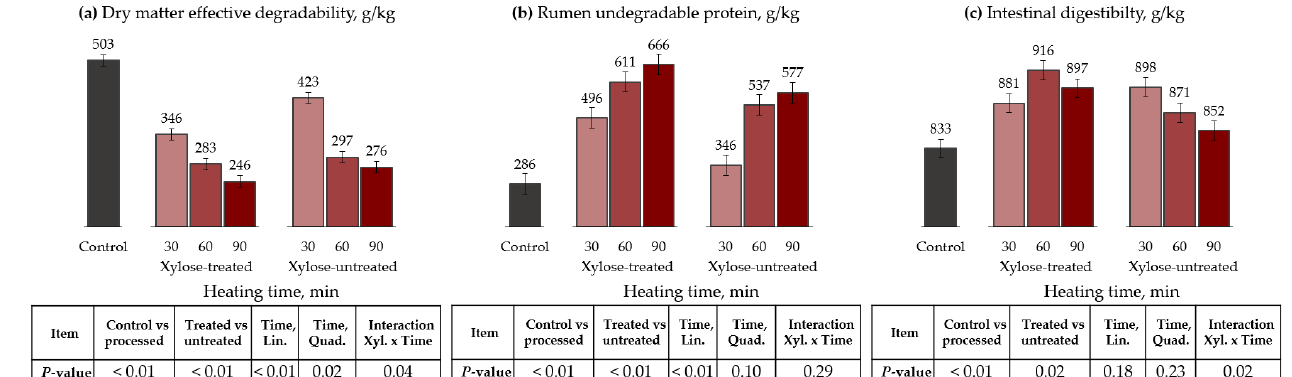
Figure 2. Effects of conventional-oven heating and xylose treatment on dry matter effective degra- dability ( a , ED), rumen undegradable protein ( b , RUP), and intestinal digestibility ( c ) of cottonseed meal. ED = A + [B × kd /(kd + kp) × e -kt ] [28]; RUP = B × [kp/(kp + kd)], where A is the water-soluble fraction, g/kg; B is the potentially degradable water-insoluble fraction, g/kg; kd is the degradation rate of fraction b, h −1 ; t is time, h; and kp is the rumen passage rate of 0.074 h −1 [28].